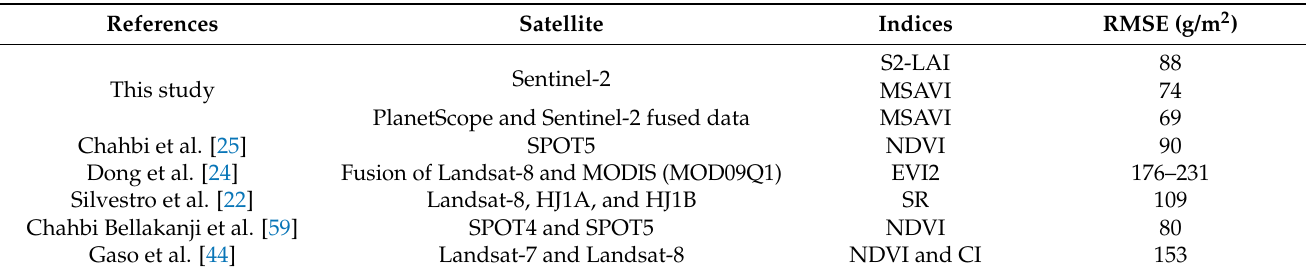
Table 2. Comparison of prediction error performance in this study with previous studies. The reported studies also used the SAFY model for wheat.